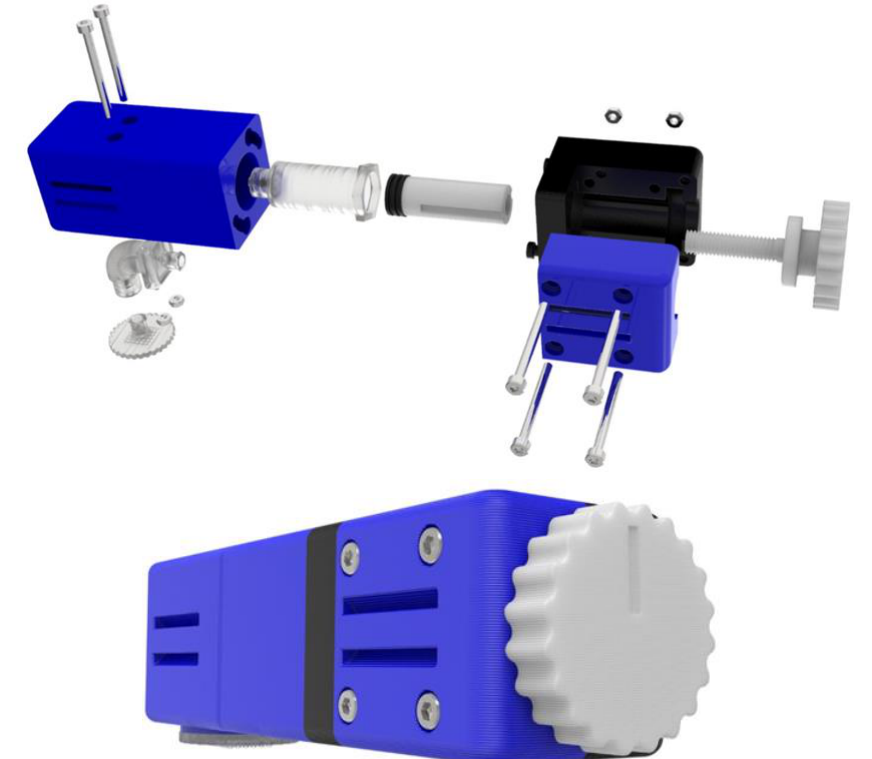
Figure 5. ( a ) Functional illustration of the mechanism and placement of the gel containing the active substance; ( b ) preparation for connection of A and B sub-assemblies; ( c ) pins joining with the cylin- drical sockets and coincidence of the surfaces of the two parts; ( d ) rotation and lock of mechanism.